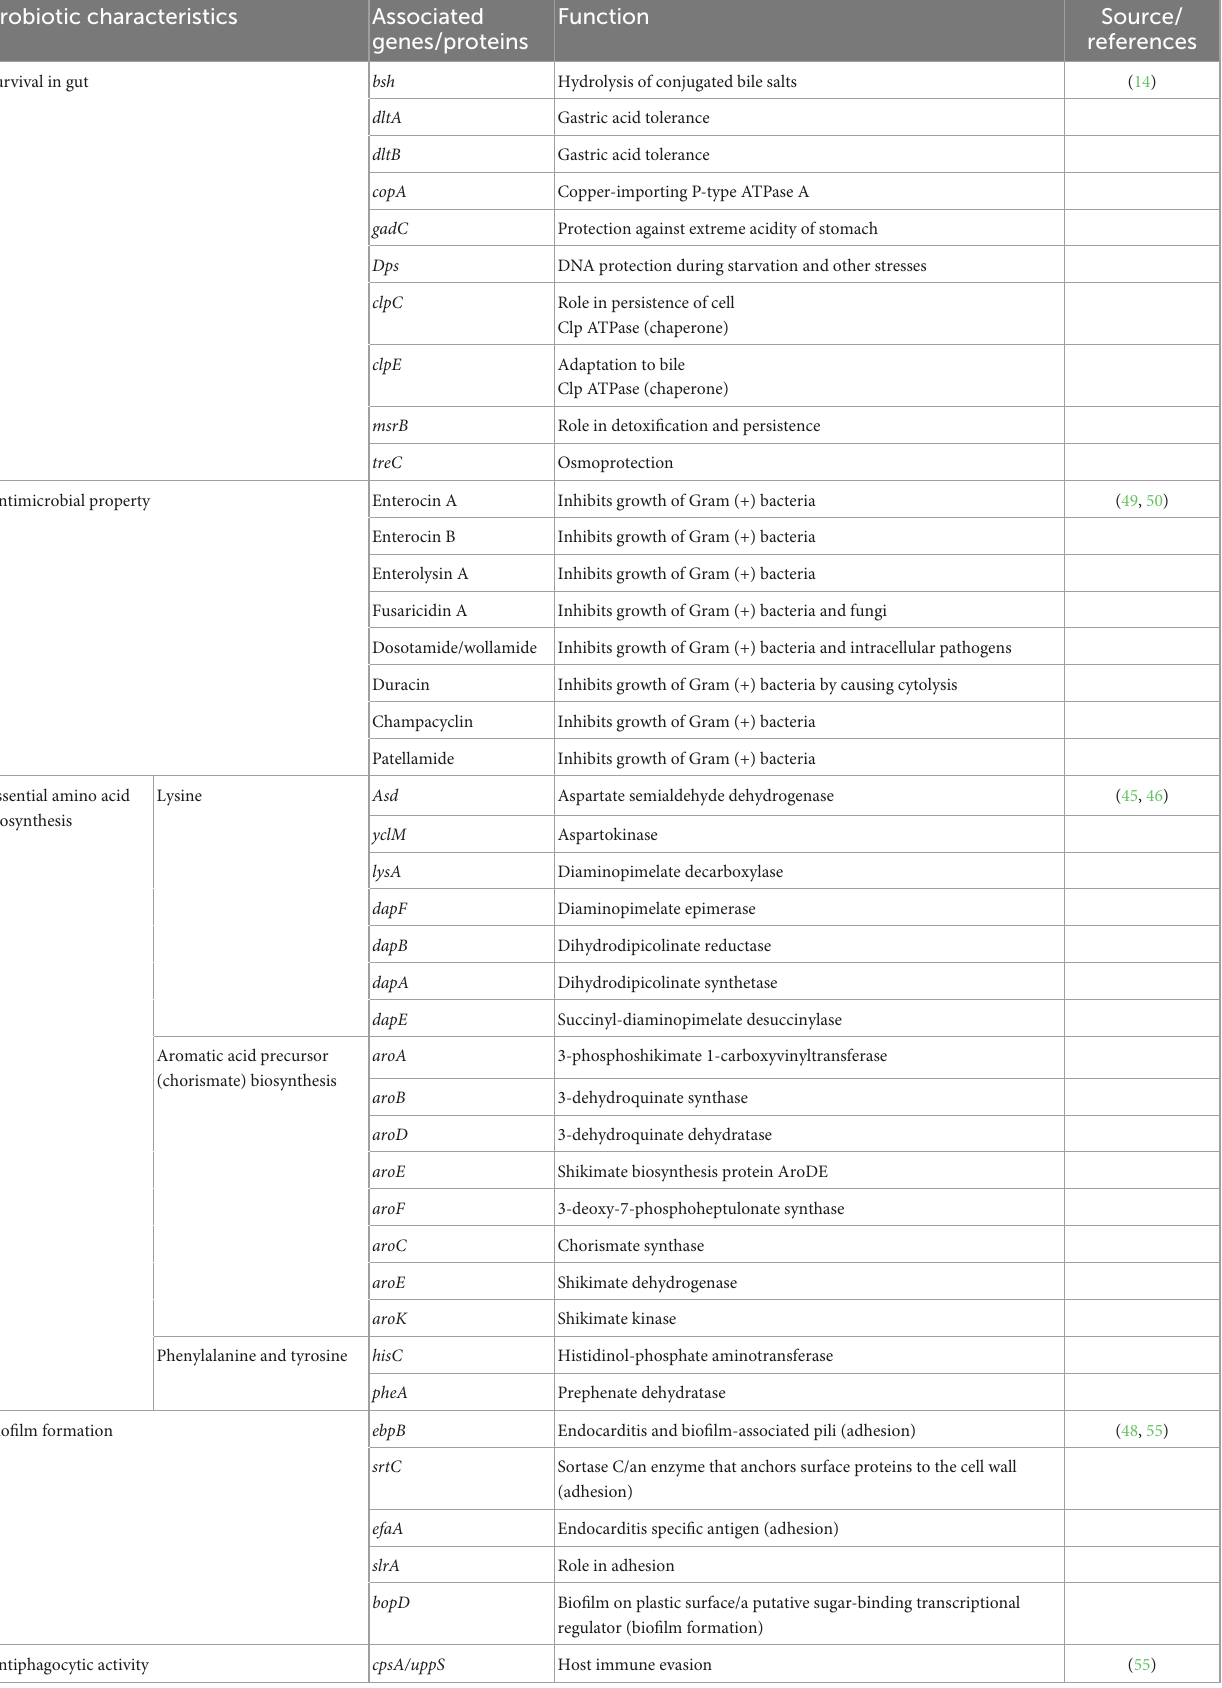
TABLE 2 Essential and desirable probiotic genes discerned in E. faecium LR13. Probiotic